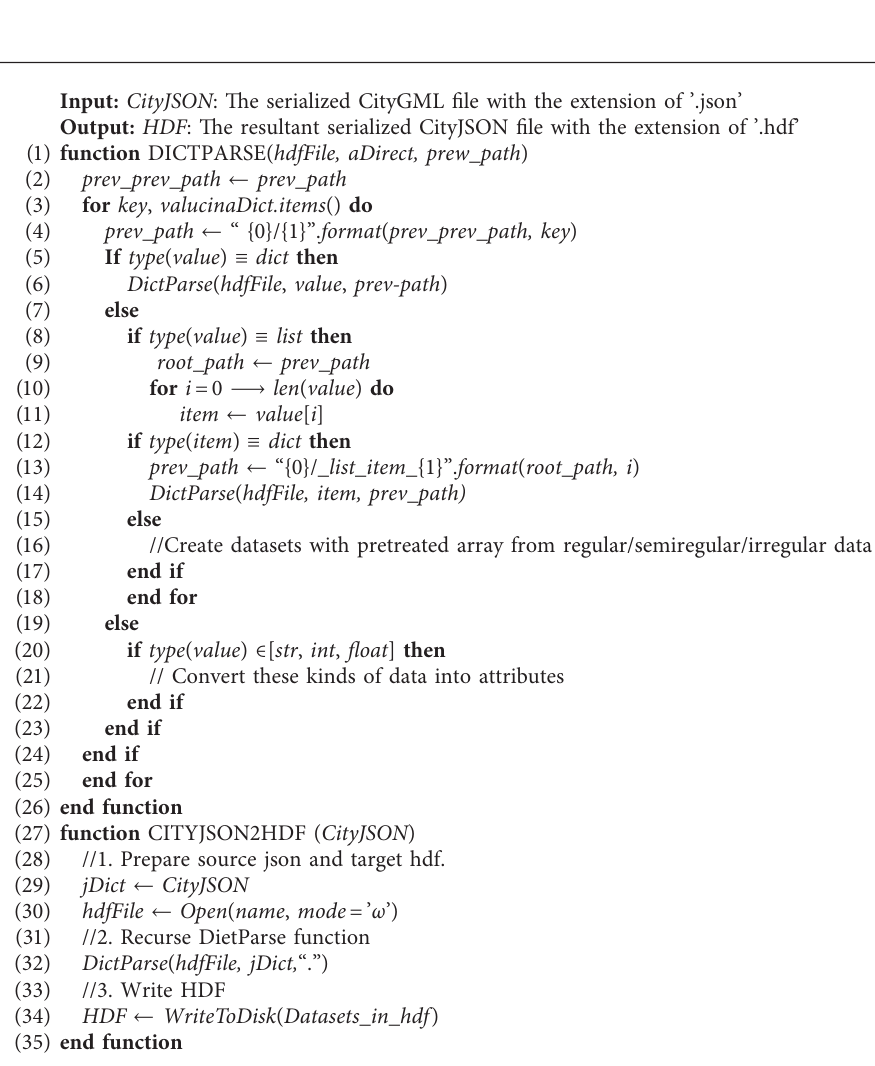
Figure 14: HDF diagram for an example CityJSON